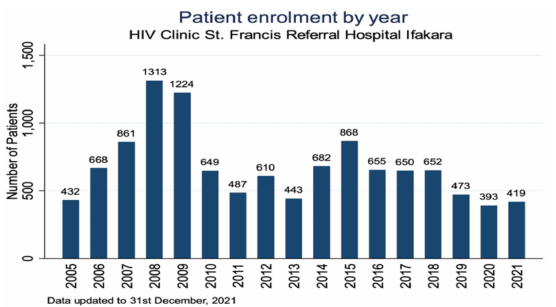
Figure 3. Yearly numbers of patients enrolled into the Kilombero and Ulanga Antiretroviral Cohort (KIULARCO) since 2005.5.